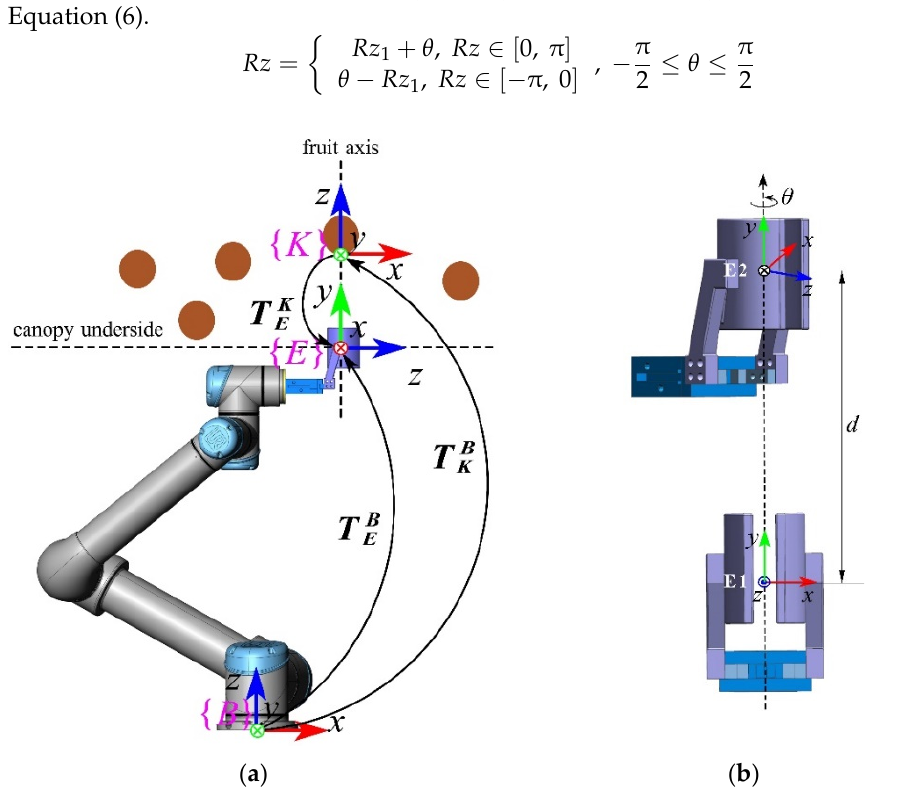
Figure 2. Schematic diagram of grasping pose: ( a ) coordinate transformation, ( b ) grasping path. Robotic-arm grasping pose E 2 can be expressed as Equation T 1